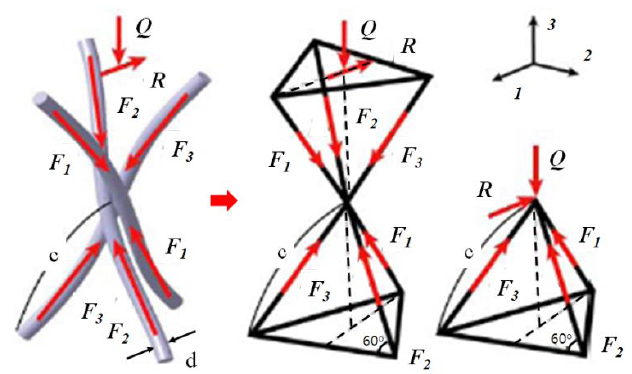
Figure 3. Ideal Kagome equivalent structures [28].